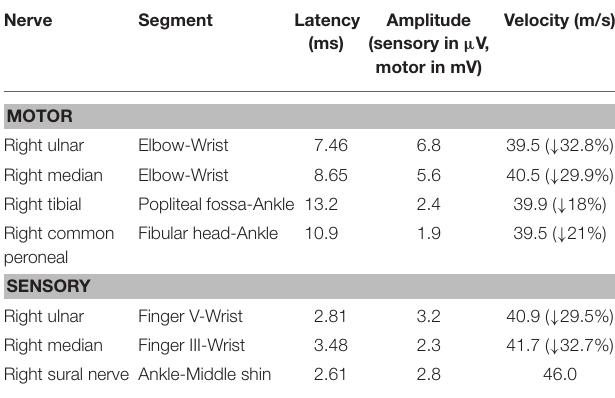
TABLE 1 | Nerve conduction